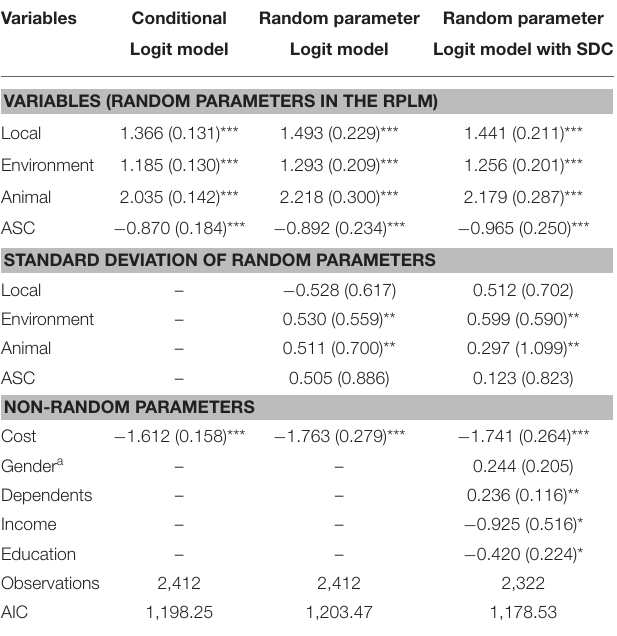
TABLE 4 | Results of conditional logit and random parameters logit